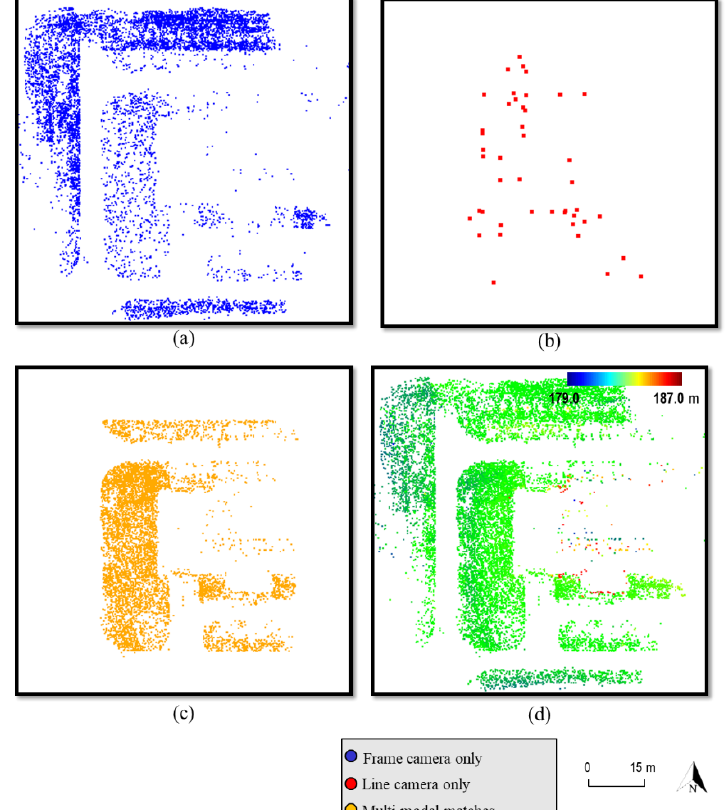
Figure 6. Top view of the 3D reconstruction results for the Building dataset: (a) ~7,800 points identified in frame camera imagery only, (b) 44 points identified in line camera scenes only, (c) ~7,500 points identified in frame and line camera imagery, and (d) all ~15,300 reconstructed points colored by